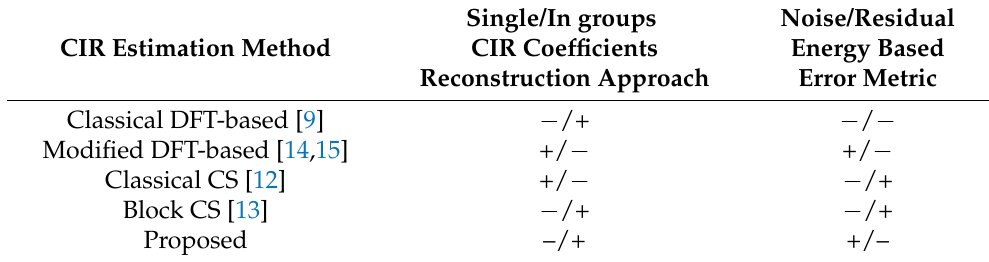
Table 1. Two main distinctive features of the compared methods (+ present/ −